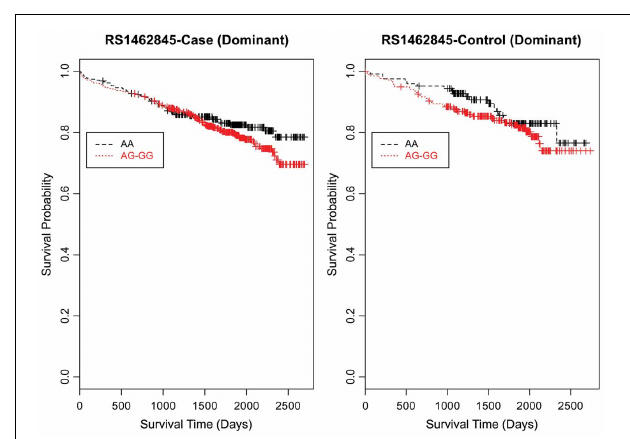
FIGURE 2 | Kaplan–Meier survival curves for CAD cases vs. controls in additive (genotype) model for LSAMP SNP rs1462845. X -axis displays the number of days from index catheterization to death (all-cause mortality). Y -axis displays the Kaplan-Meier survival probability by genotype. G is the minor allele; AA, wild-type genotype (reference; black curve); AG, heterozygous genotype (blue curve); and GG, risk homozygous genotype (red curve).